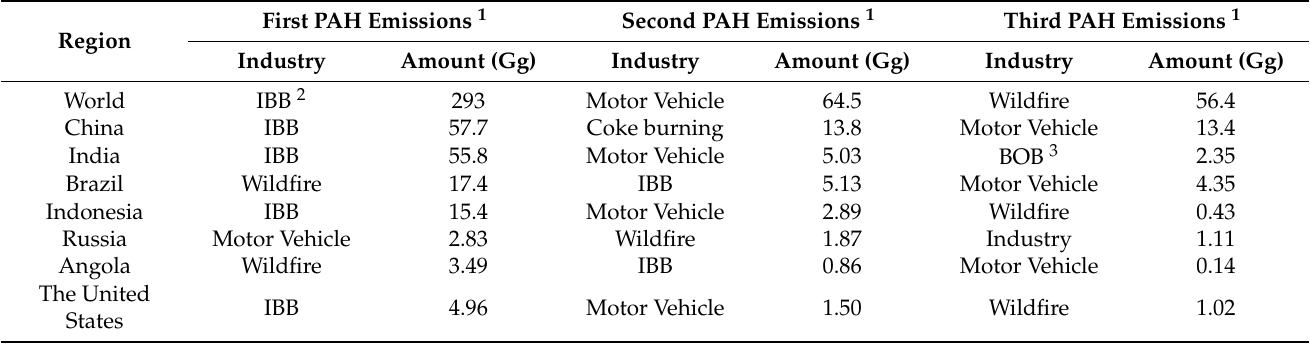
Table 1. Top three industries in PAHs emissions in different countries and around the